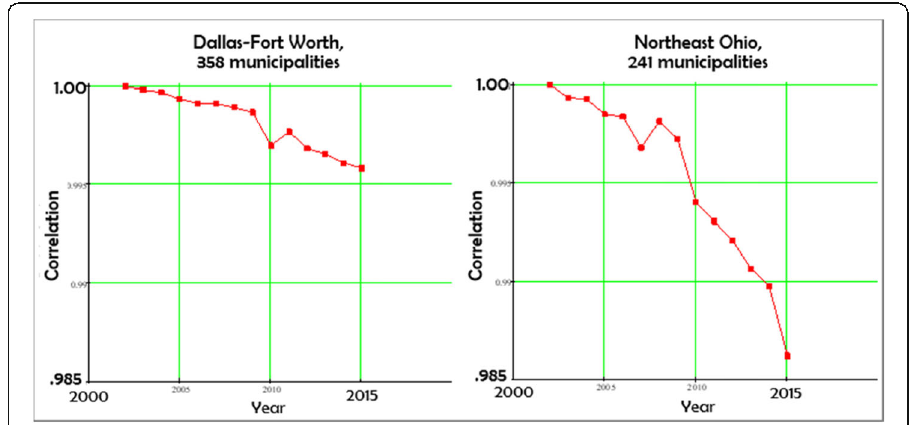
Fig. 5 Correlations between actual and predicted employment by municipality, Dallas-Fort Worth